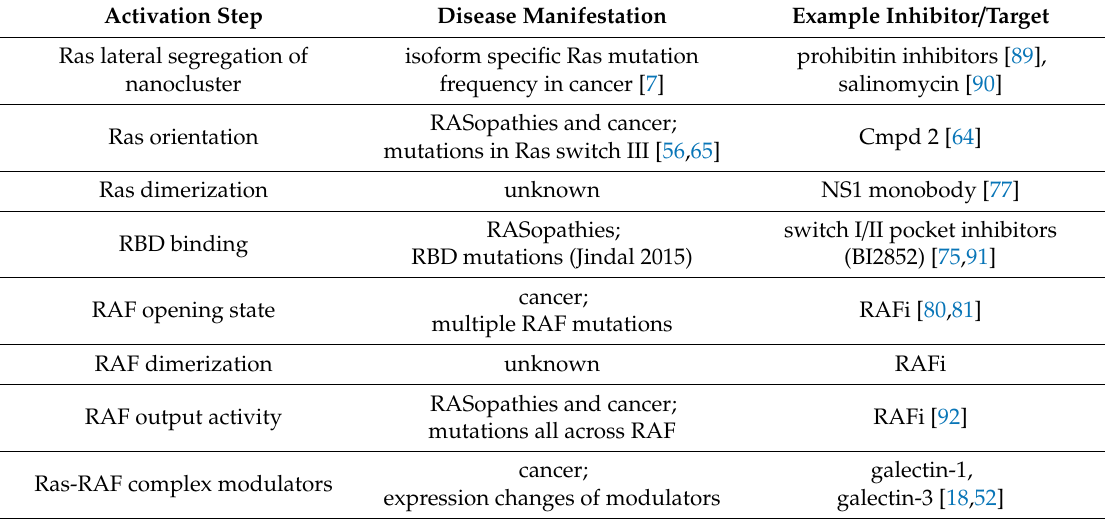
Table 1. Disease manifestations of critical Ras-RAF activation steps and potential inhibitors or drug